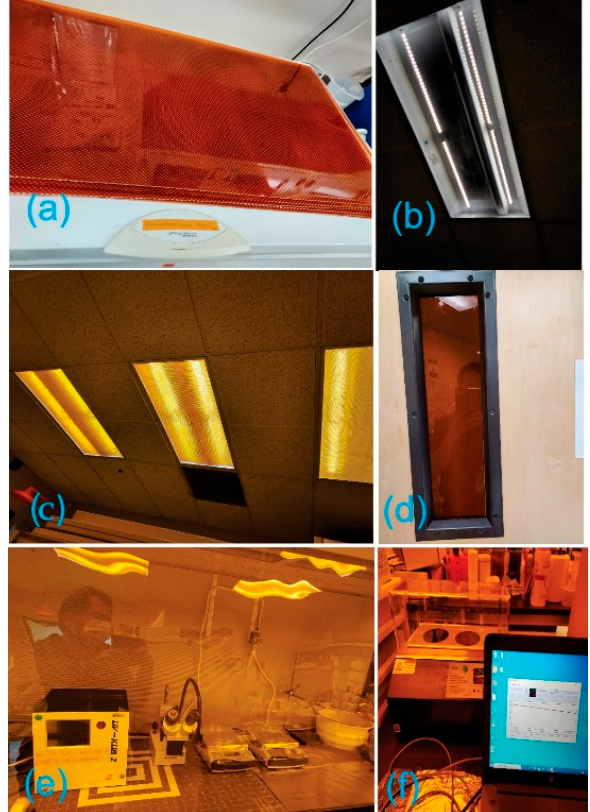
Figure 3. Digital pictures of ( a ) UV ‐ protected films (durXtreme GmbH, Germany); ( b ) lab’s ceiling before and ( c ) after covering with UV ‐ protected films; ( d ) covered lab window; ( e , f ) lab space after implementing UV ‐ protected films.